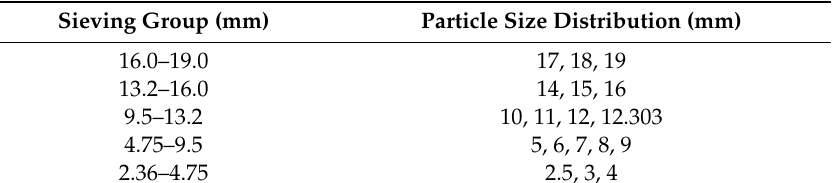
Table 14. Particle size distribution of the steel balls.